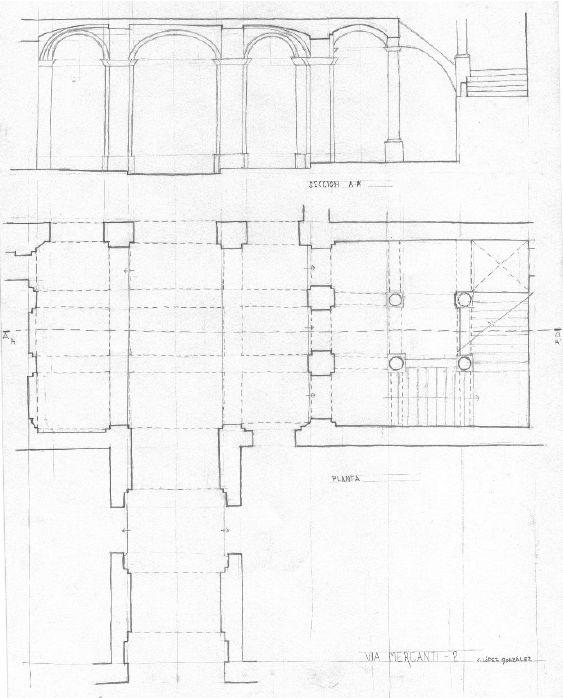
Figure 6. Previous preparation drawing. Section and plan of the atrium. Drawing: M. C. López González that envelops the observed object (Ramos, Marchamalo, Rejas y Martínez, 2015).